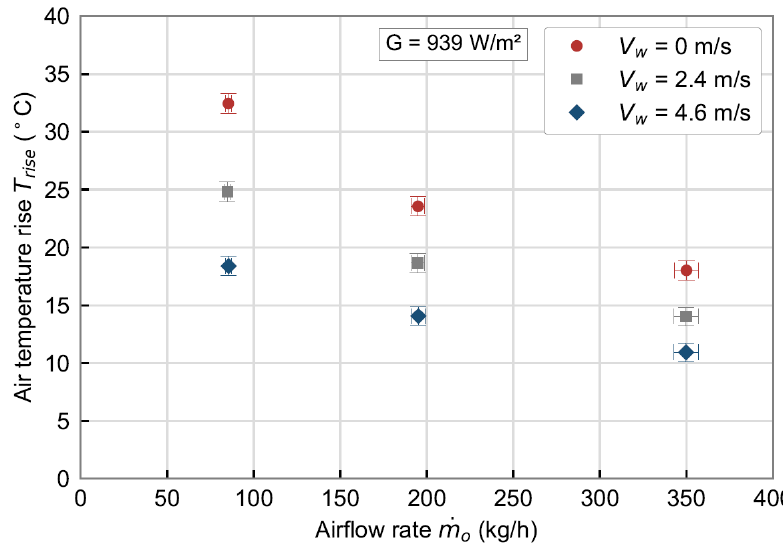
Figure 11. Temperature rise dependency to flowrate and wind speed.